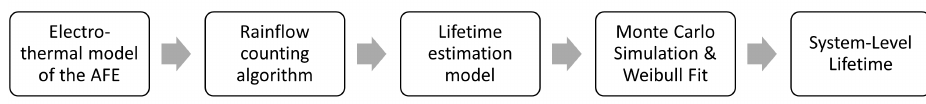
Figure 39. Process of AFE reliability